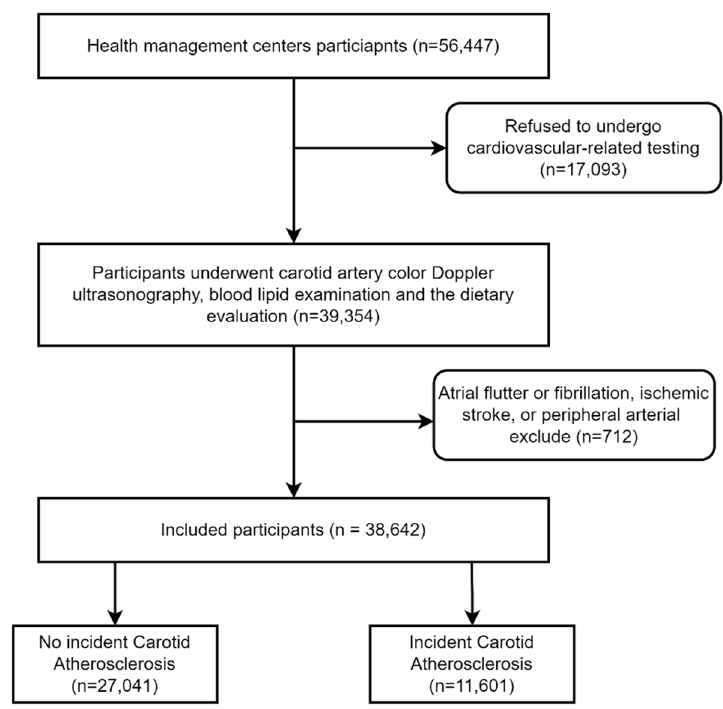
Figure 1. Flowchart of this study.